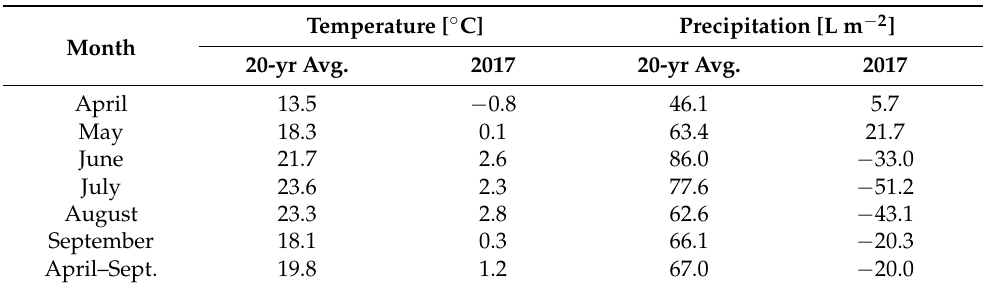
Table 1. Difference in climate variables between vegetative period for 20-yr average (1997–2016) and for the 2017